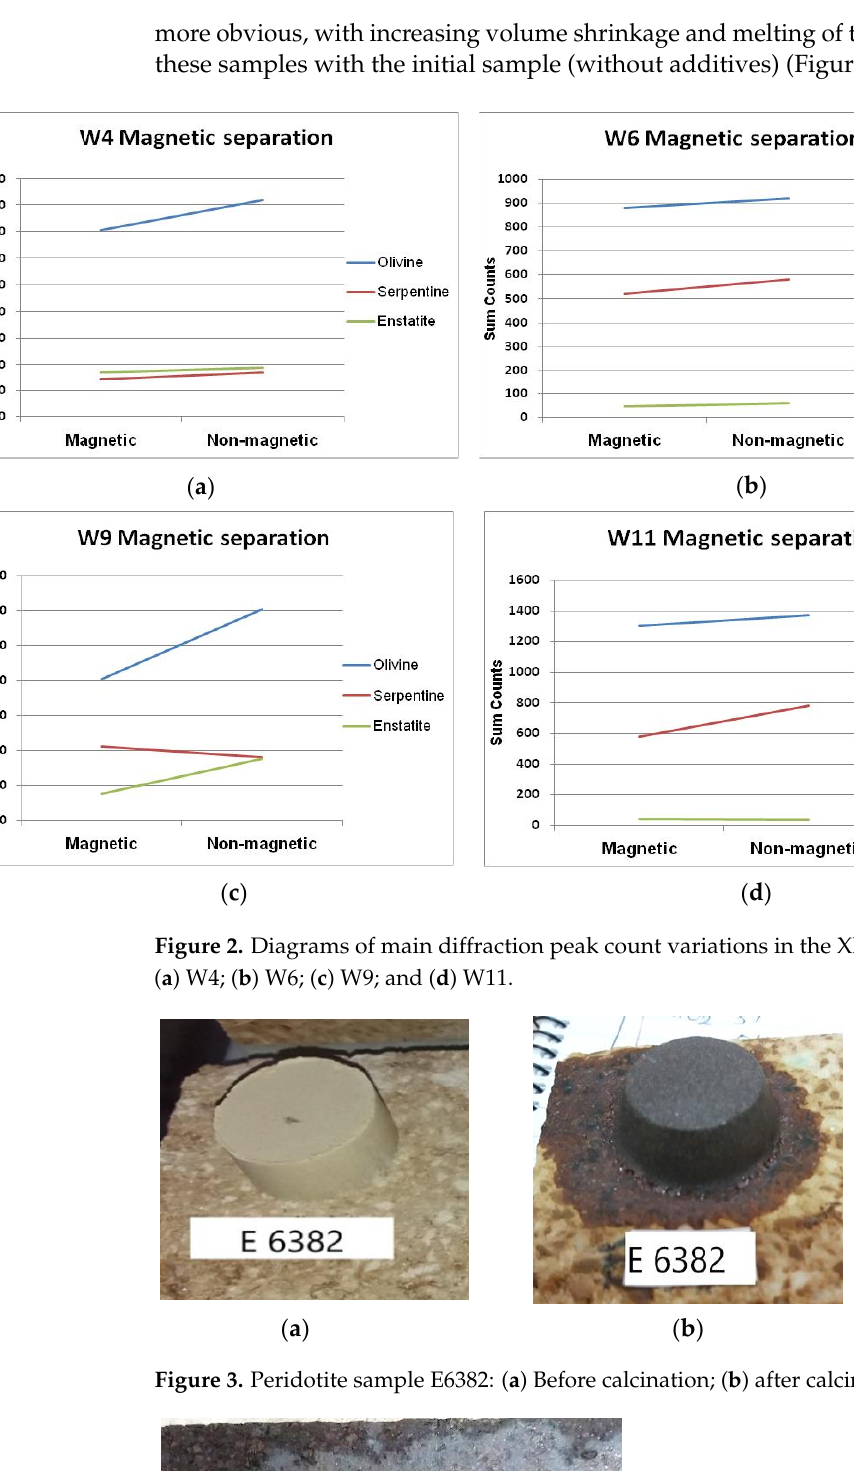
Figure 3. Peridotite sample E6382: ( a ) Before calcination; ( b ) after calcination. Figure 4. Peridotite sample E6382 with the CaO addition after calcination. Figure 4. Peridotite sample E6382 with the CaO addition after